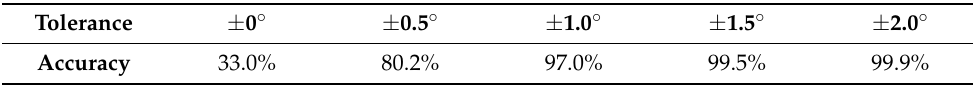
Table 3. Estimation accuracy at each tolerance (correct answer rate).